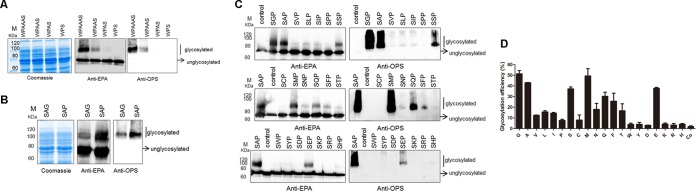
Optimization of the recognition motif. (A) The middle 4 amino acids (GNNT) of the recognition motif were replaced with single, double, or triple alanines or were removed completely. Plasmids containing these sequences were transformed into strain 301DWP, and glycosylation was detected by Western blotting. (B) A G65P mutant was constructed based on the sequence 57WPAAASAG65. This sequence was used and assessed as described for panel A. (C) The A after S63 was mutated into one of each of the other 19 amino acids. After plasmids with each of these sequences were transformed into strain 301DWP and protein expression was induced, periplasmic fractions were extracted and a Western blot analysis was performed to detect which sequences resulted in glycosylation. Control indicates the control group that expressed the carrier protein only (pET-pglLmut-rEPAMOOR-AA). (D) Western blotting assays were performed as in panel C. The glycosylated and unglycosylated bands of each lane were framed and used in a volume analysis performed by using the software Quantity One. The bar graph shows the percentage of glycosylated proteins for each transformant of 301DWP. “Co” indicates the control group, and the error bars indicate the standard deviations.